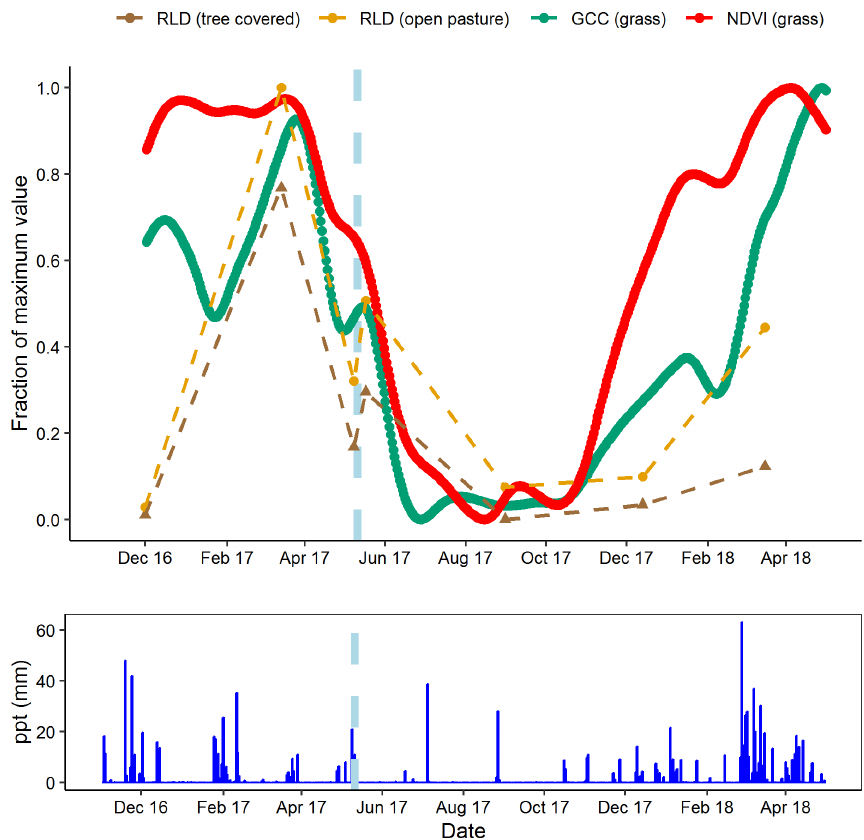
Figure 8. Comparison of minirhizotron root length density (RLD, mmmm − 2 ) dynamics at 9cm in depth for open pasture with site-level grassland. Normalized difference vegetation index (NDVI) and grassland green chromatic coordinate (GCC). After the rain pulse in May 2017 (indicated on graph, light blue dashes), minirhizotron measurements could detect the similar response to above ground (shown in more detail in Fig. 7). Desynchronization was evident in both autumn periods where proximal remotely sensed metrics reached near-peak levels while RLD remained